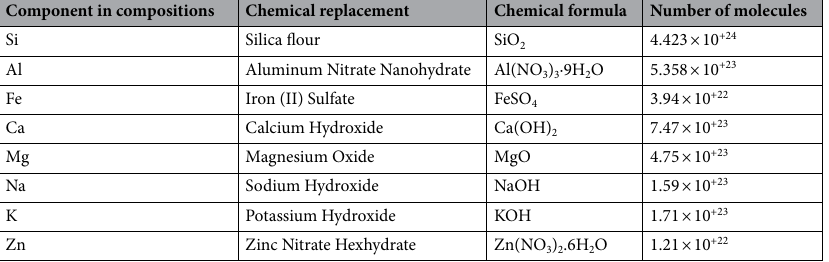
Table 5. List of composition, chemical replacement, and number of molecules for each replaced element.